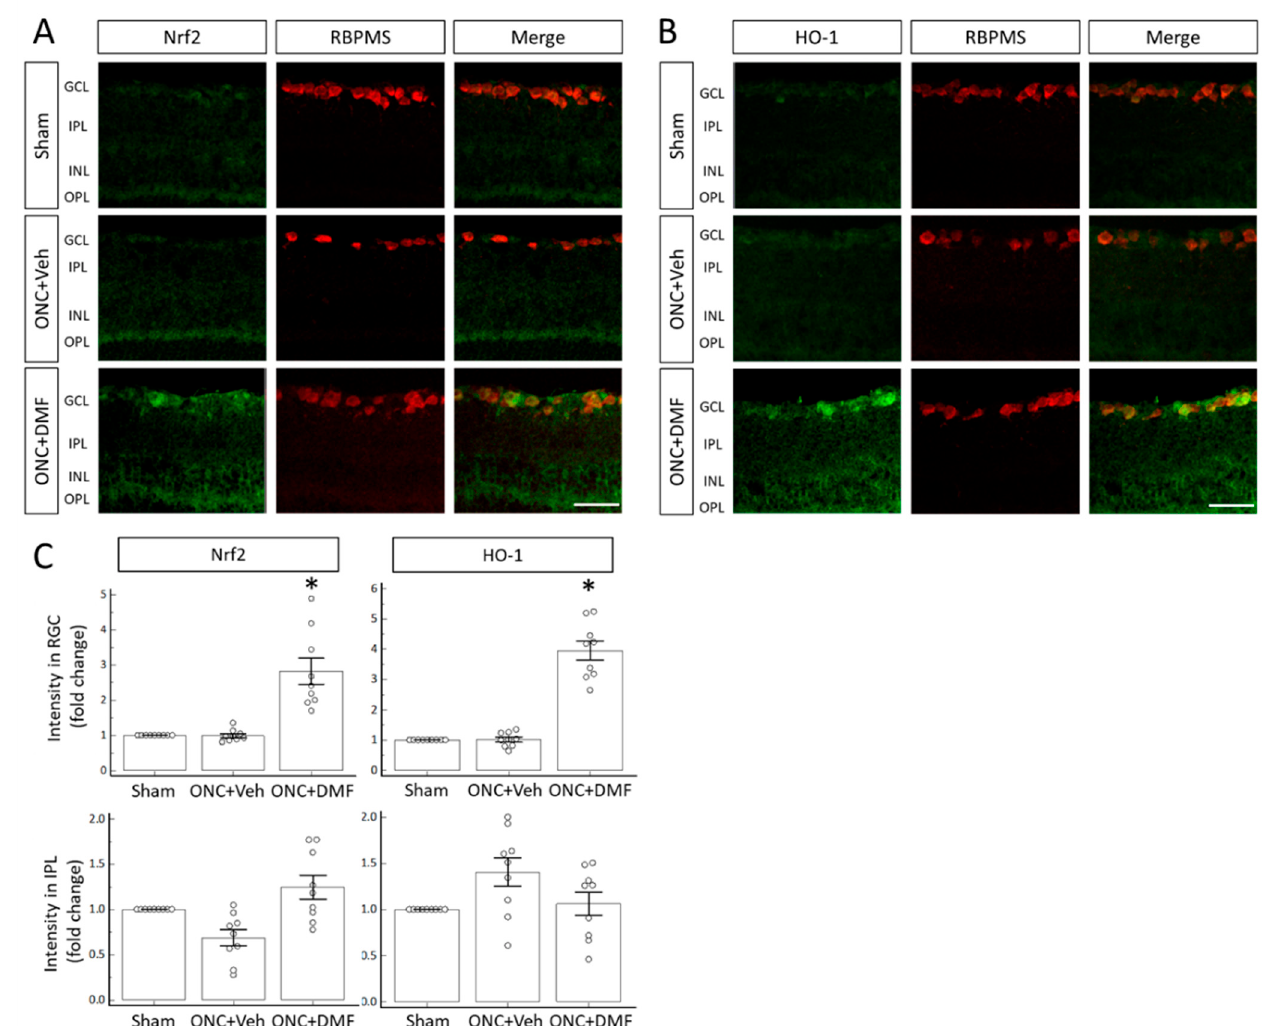
Figure 3. NF-E2-related factor 2 (Nrf2) and heme oxygenase-1 (HO-1) expression in the retina. (A) Immunoreactivities of Nrf2 and RNA-binding protein with multiple splicing (RBPMS). ( B ) Immunoreactivities of HO-1 and RBPMS. ( C ) Quan- titative comparison of the immunoreactivities of Nrf2 and HO-1 in RGCs and the inner plexiform layer (IPL). DMF was administered orally at a concentration of 100 mg/kg. Each circle denotes the individual estimated values based on nine different retinal images (three different images from each animal). Asterisks indicate p < 0.05 ( n = 9 each) compared to ONC with the vehicle (unpaired t -test). Scale bar = 50 μ m.